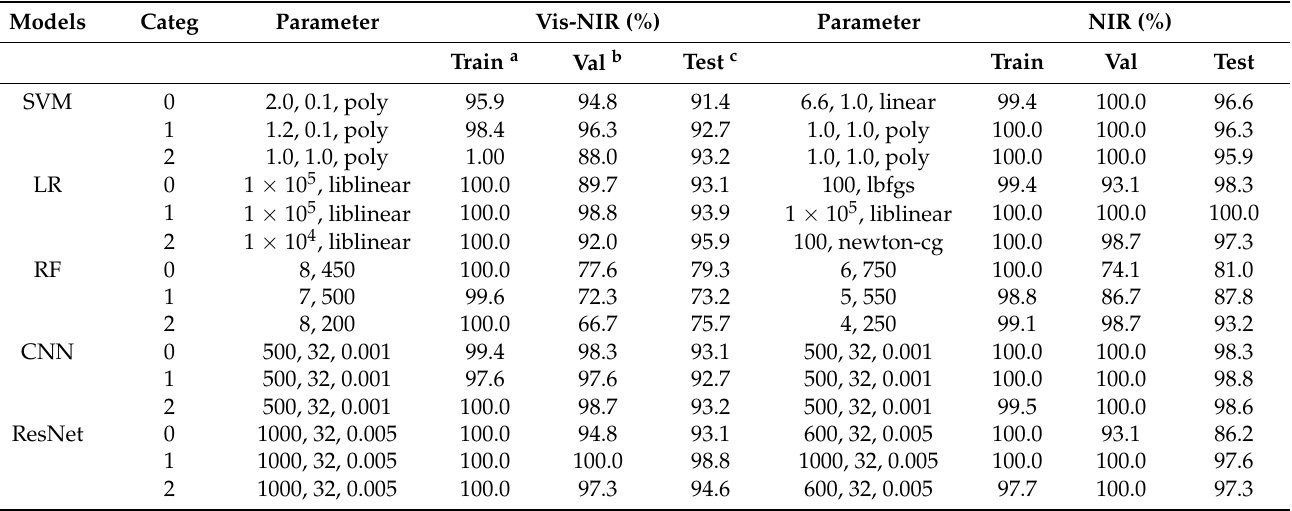
Table 4. The classification of the accuracy of the logistic regression (LR), support vector machine (SVM), random forest (RF), convolution neural network (CNN), and residual neural network